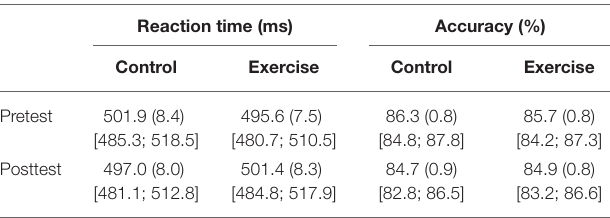
TABLE 4 | n-back data: pre- and posttest scores in the control and exercise session (means, standard errors, and 95% confidence